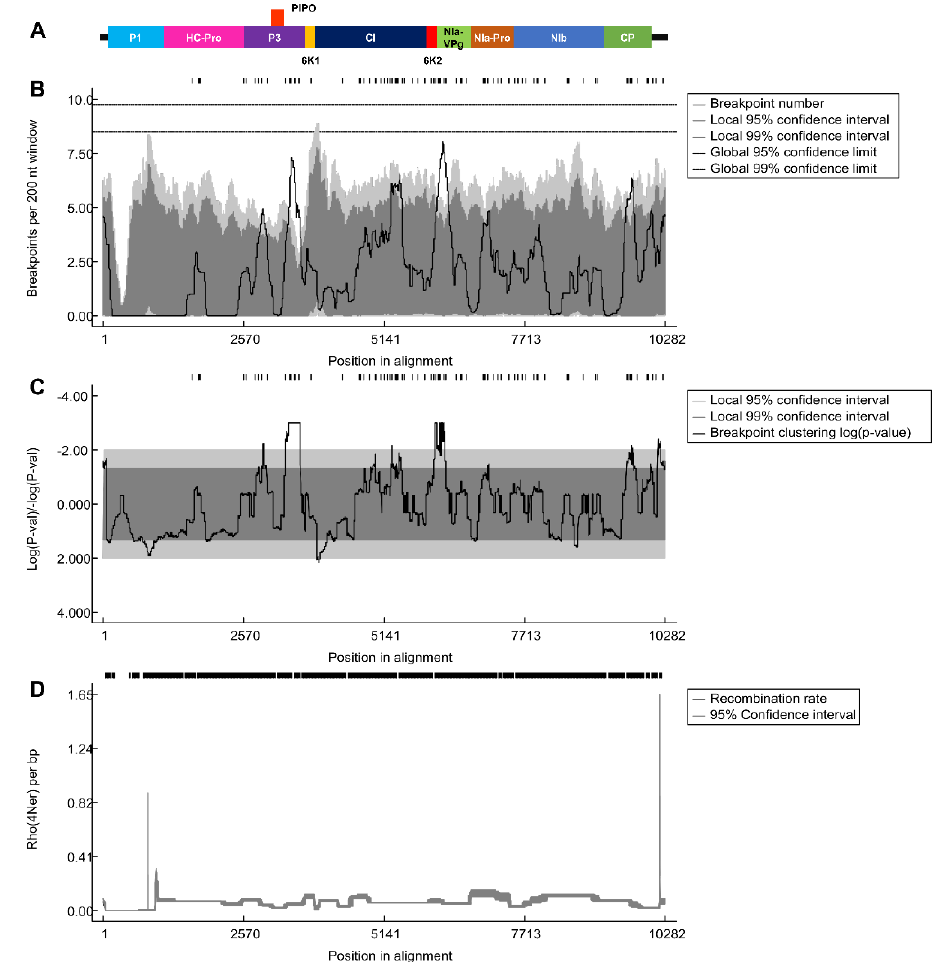
Figure 5. Recombination breakpoint distribution plots for the SMV genome. SMV genome organi- zation showing individual protein regions ( A ). Recombination breakpoint distribution plot ( B ) and respective statistical log converted p -value ( C ). Locally and globally significant breakpoint clusters were identified using 95% and 99% permutation tests. Recombination rate plot ( D